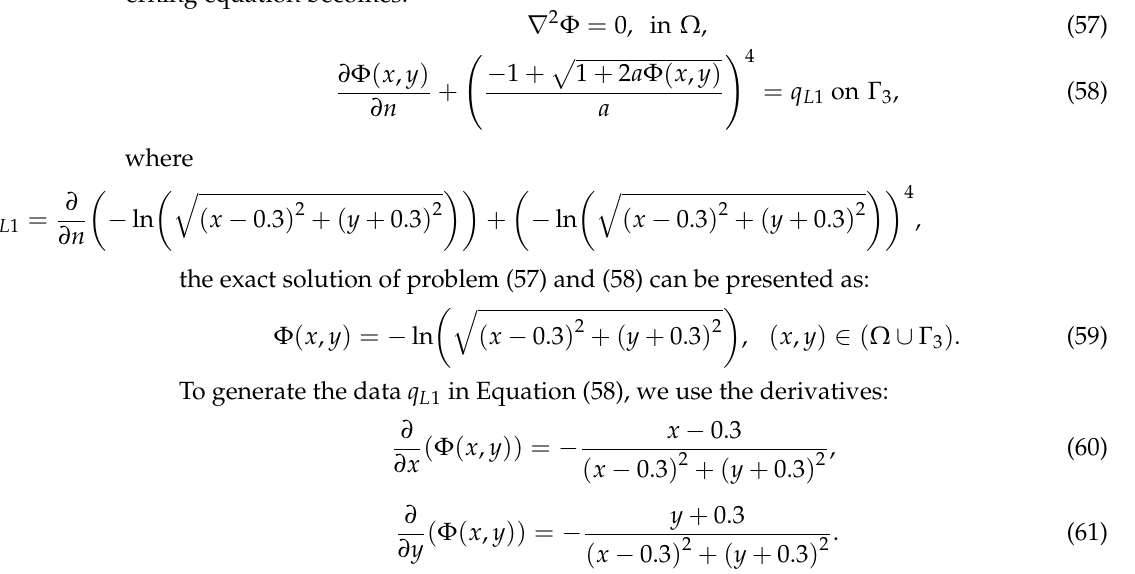
Figure 7. Schematic of the computational domain of case 3.